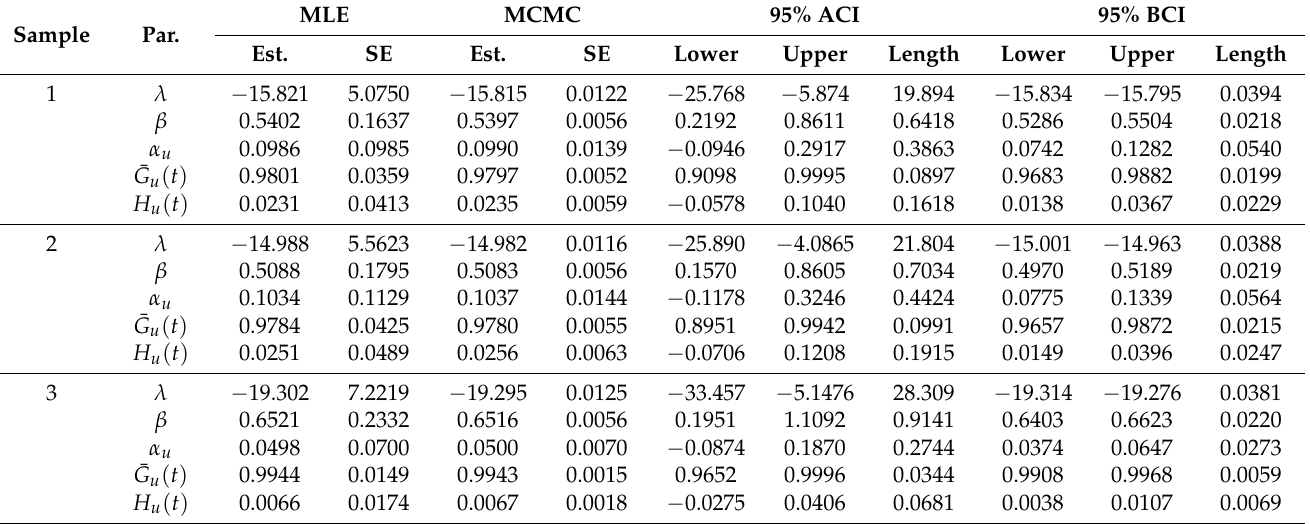
Table 3. Point and interval estimates from OBT data.